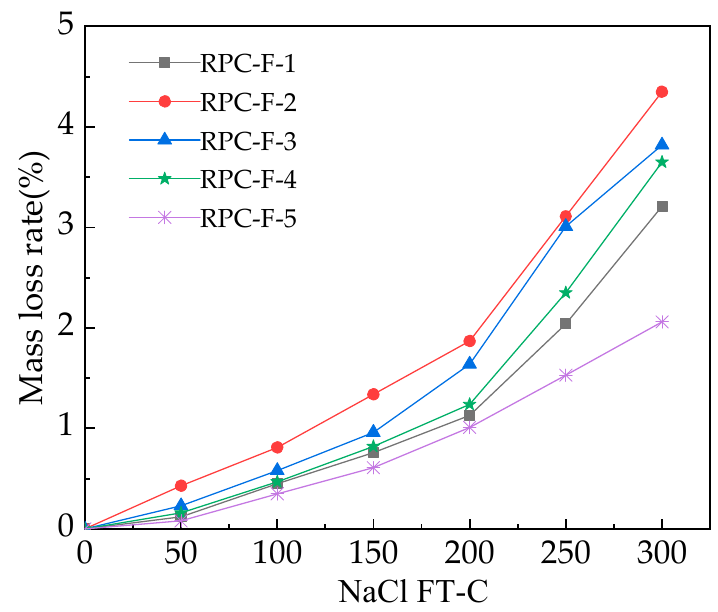
Figure 4. Mass loss rate during NaCl FT-C.